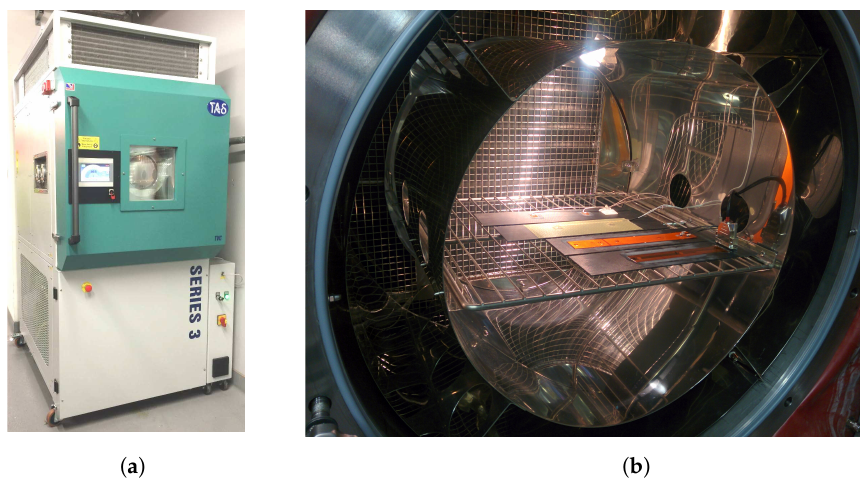
Figure 6. TAS Series 3 test chamber ( a ); test section ( b ).